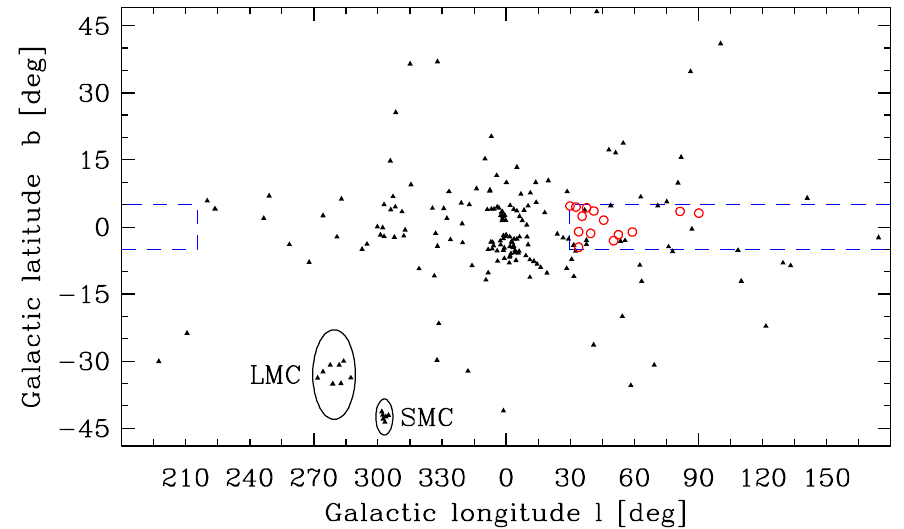
Fig. 1. Distribution of the new IPHAS symbiotic stars (empty circles), compared to the previously known systems (triangles). Three known objects with j b j > 50 ◦ fall outside the graphic. The limits of the area surveyed by IPHAS are indicated by the dashed line.